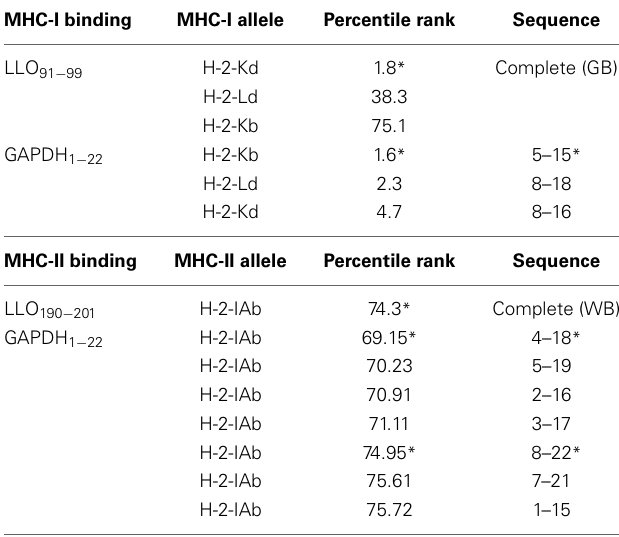
Table 2 | MHC-I and MHC-II binding force predictions for LLO and GAPDH